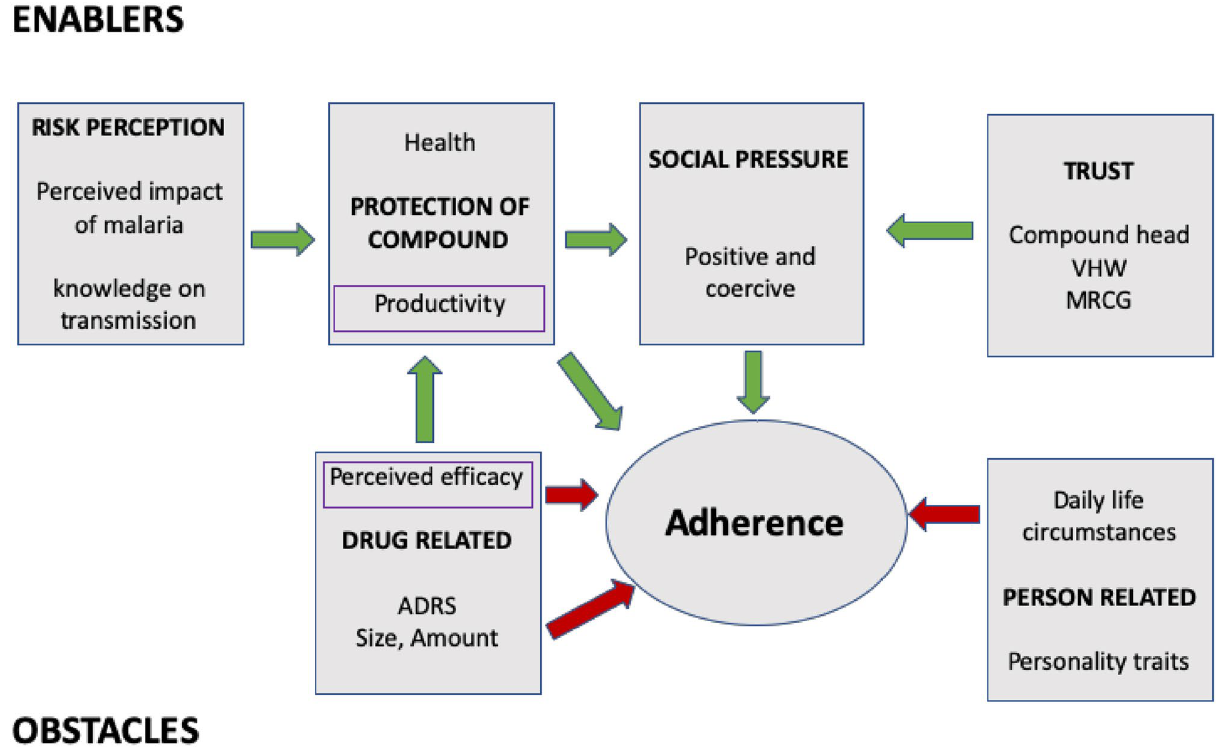
Figure 2. A general adherence model depicting the factors related to enablers and